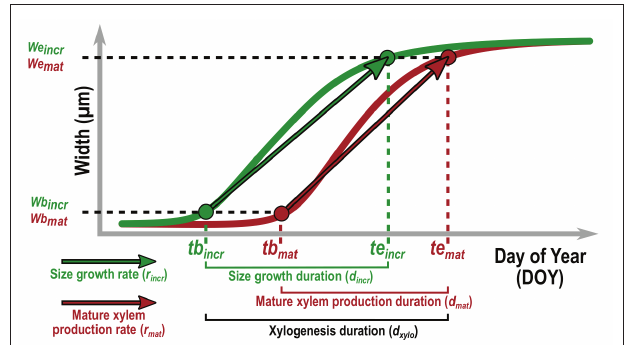
FIGURE 5 | Description of the xylogenesis parameters estimated for both HXRCT and microtomy datasets. Parameters related to size growth (green) and mature xylem production (brown) are reported. The date of beginning ( tb incr ) and ending ( te incr ) of size growth are defined as the day of year for which, respectively, 5% and 95% (i.e., wb incr and wc incr ) of the increment is formed. The date of beginning ( tb mat ) and ending ( te mat ) of mature xylem production are defined as the day of year for which, respectively, 5% and 95% (i.e., wb mat and wc mat ) of the mature xylem is formed. The duration of size growth ( d incr ), mature xylem production ( d mat ) and xylogenesis ( d xylo ) are computed as the time span between te incr and tb incr , te mat and tb mat , and te mat and tb incr respectively. The average daily rate of size growth and mature xylem production are calculated as, r incr = ( we incr − wb incr ) / ( te incr − tb incr ) and r mat = ( we mat − wb mat ) / ( te mat − tb mat